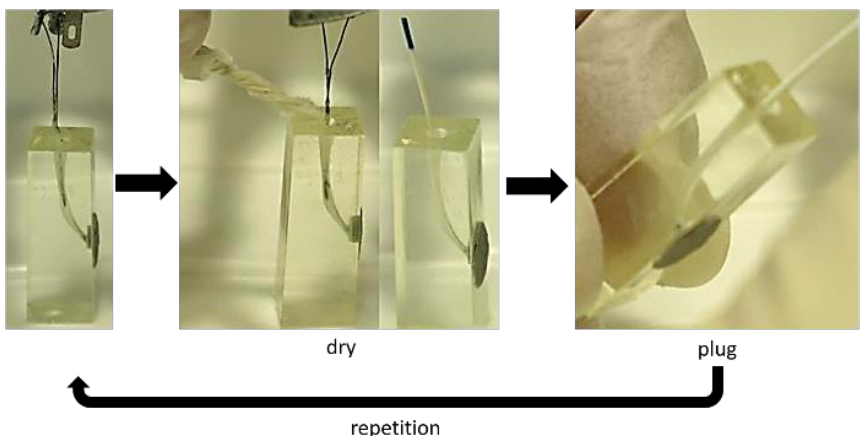
Figure 2. Obturation procedure for the endo practice blocks. The canals were filled with CaP precursor solution and the glued wire BDD prototype was inserted into the canal. The precipitate was dried and condensed before starting the next precipitation cycle until the apical third was filled with precipitate.